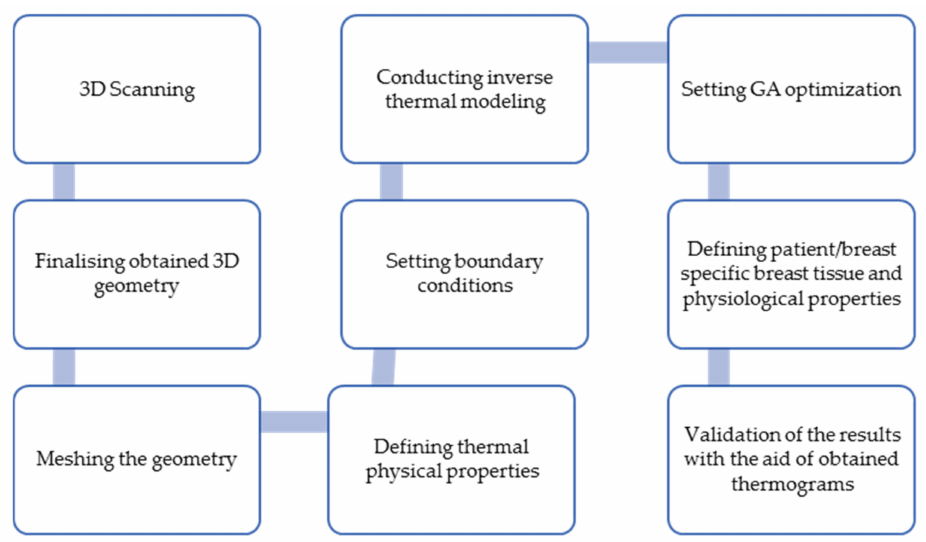
Figure 9. Block diagram of the proposed research.